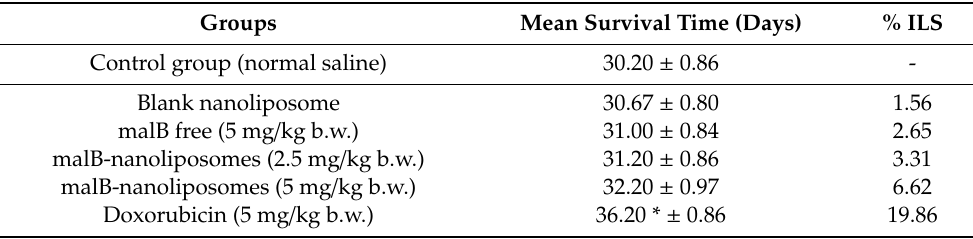
Table 4. E ff ect of malB-nanoliposome and free malB on survival time of LLC-induced tumor-bearing mice from di ff erent experimented groups (mean ± SEM) ( n = 6